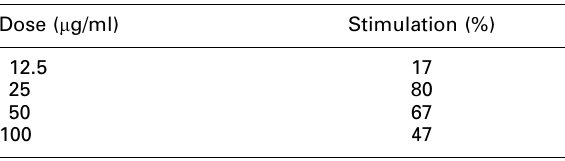
Results are expressed as percentage of